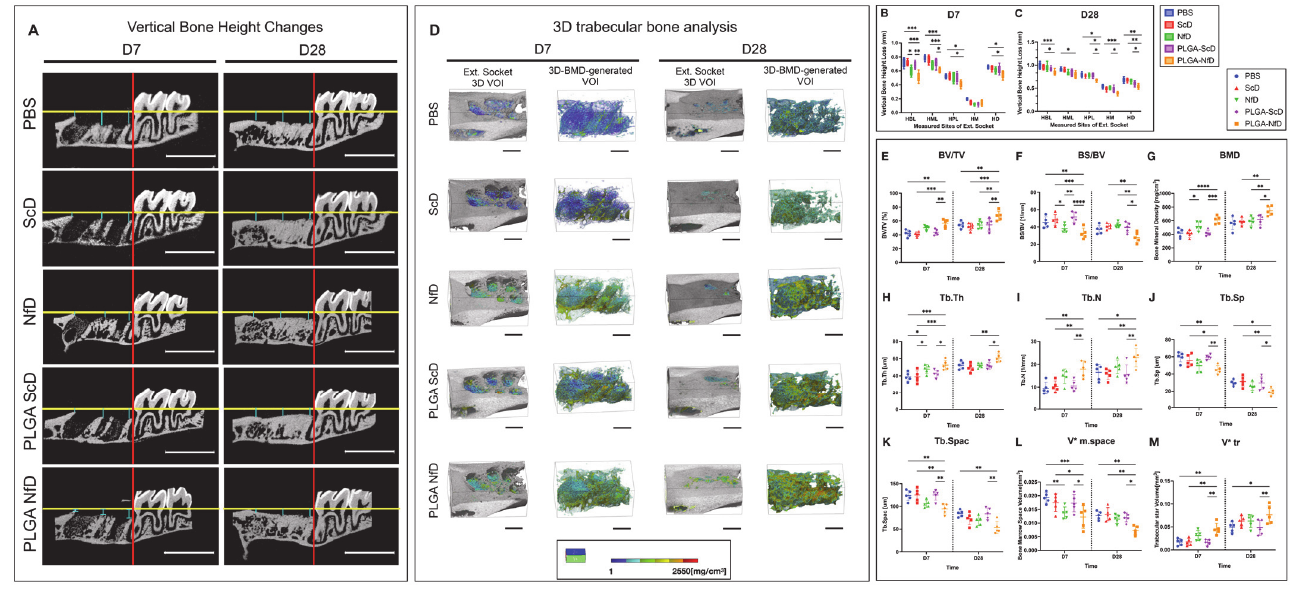
Figure 1. PLGA-NfD prevents vertical bone loss of the tooth-extraction socket and preserves the alveolar ridge. ( A ) Sagittal view of representative microcomputed tomography images. Blue lines indicate the extent of vertical alveolar bone loss in each group. ( B , C ) Linear measurement of the loss of vertical height was defined by vertical height changes of the socket. Measurements were performed in the VOI from the cement–enamel junction of M3 to the alveolar bone crest of the socket (scale bar = 3 mm). ( D ) Representative three-dimensional (3D) images of the VOI at the tooth-extraction socket. Trabecular 3D-BMD-generated VOI was used as the area of measurement for the alveolar bone analysis. The BMD value is indicated by the BMD color transition scale (scale bar = 1 mm). ( E – M ) 3D microcomputed tomography trabecular bone analysis of the tooth-extraction socket on D7 and D28. On D7, the PLGA-NfD and NfD groups showed an increase in BV/TV, BMD, Tb.Th, Tb.N, and V*tr and a decrease in BS/BV, Tb.Sp, Tb.Spac, and V*m.space; on D28, the PLGA-NfD group showed an increase in BV/TV, BMD, Tb.Th, Tb.N, and V*tr and a decrease in BS/BV, Tb.Sp, Tb.Spac, and V*m.space. Values are presented as mean ± standard deviation ( n = 5). * p < 0.05, ** p < 0.01, *** p < 0.001, and **** p < 0.0001. Abbreviations: BMD, bone mineral density; BS/BV, bone